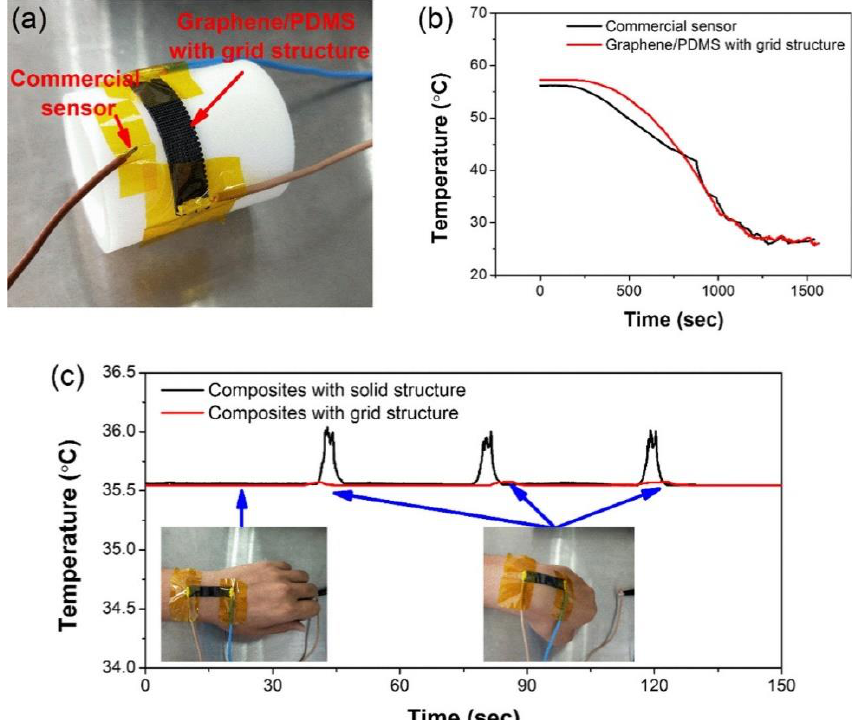
Figure 4. “ Monitoring of the cooling process on a curved surface: ( a ) experimental setup; ( b ) com- parison of the temperature performance between graphene/PDMS composites with a grid structure and commercial temperature sensor; and ( c ) simultaneous monitoring of wrist skin temperature and joint bending.” [Z. Wang et al., “3D-Printed Graphene/Polydimethylsiloxane Composites for Stretchable and Strain-Insensitive Temperature Sensors,” ACS Appl. Mater. Interfaces , vol. 11, no. 1, pp. 1344–1352, Jan.